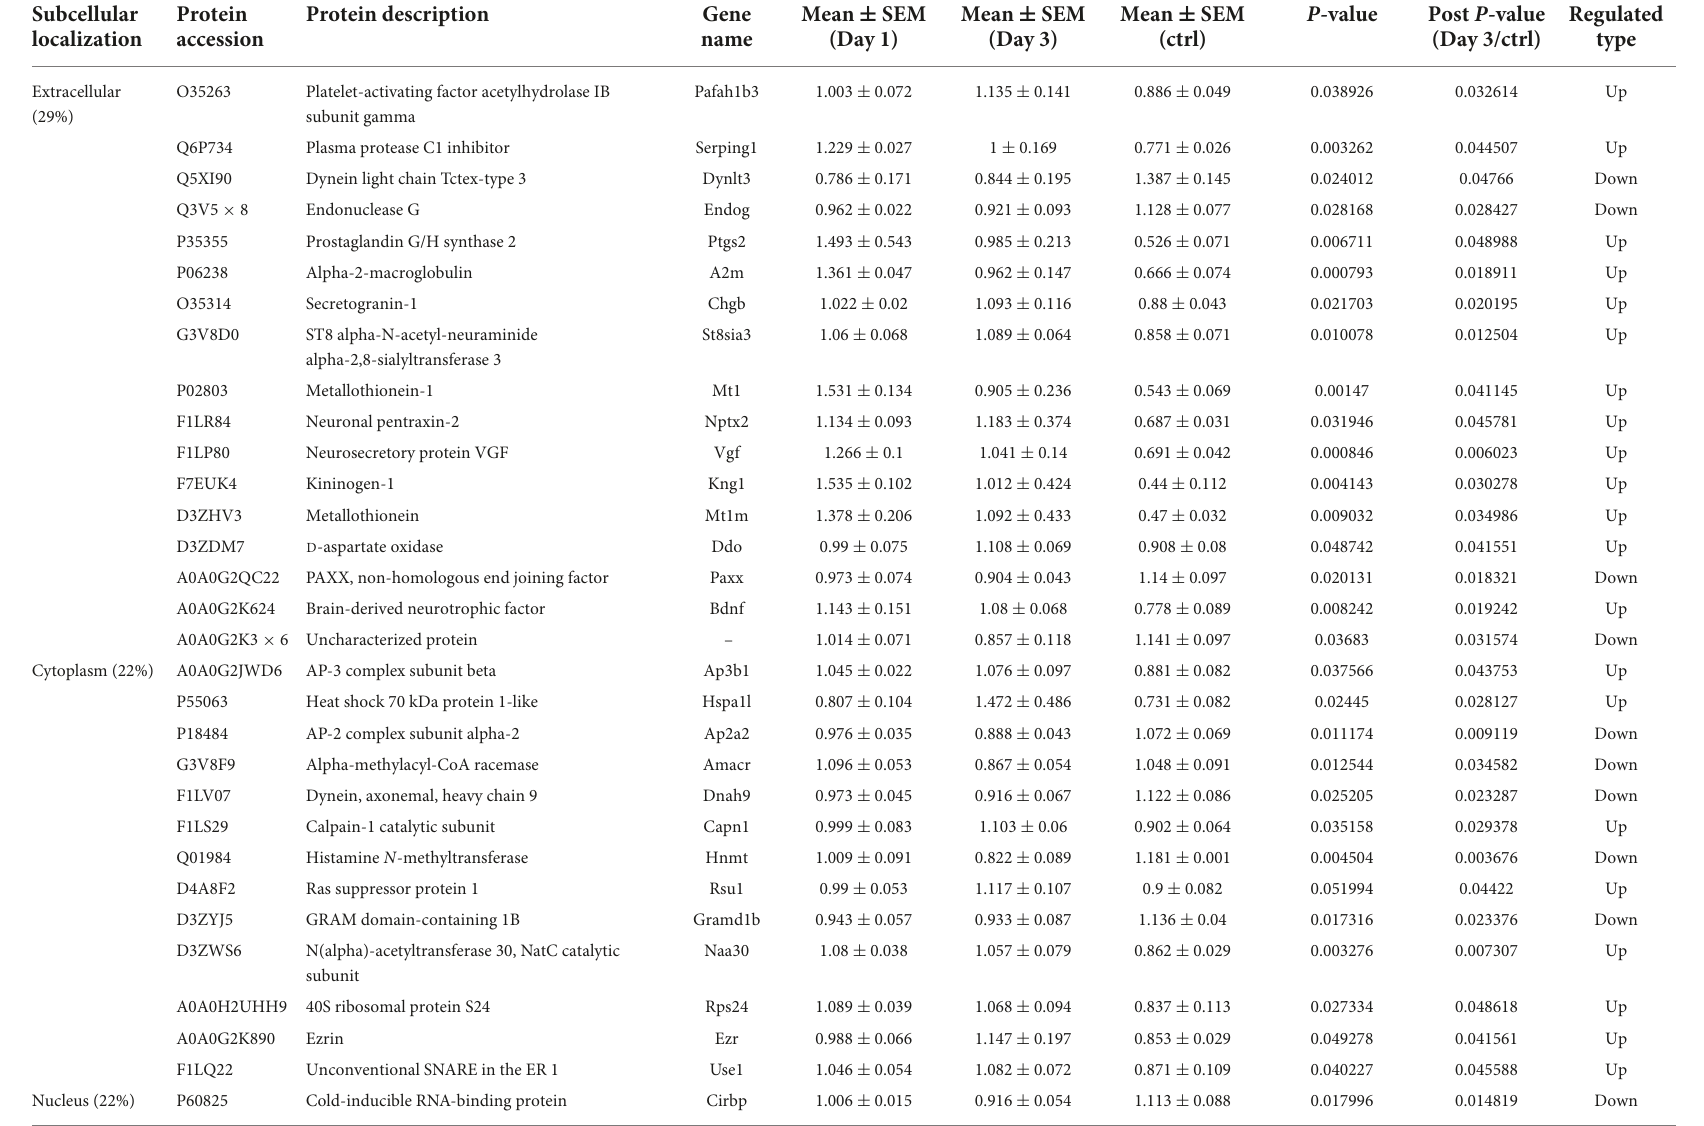
TABLE 5 Cellular distribution of differentially expression proteins on Day 3 comparing with control (ctrl) by ANOVA analysis in